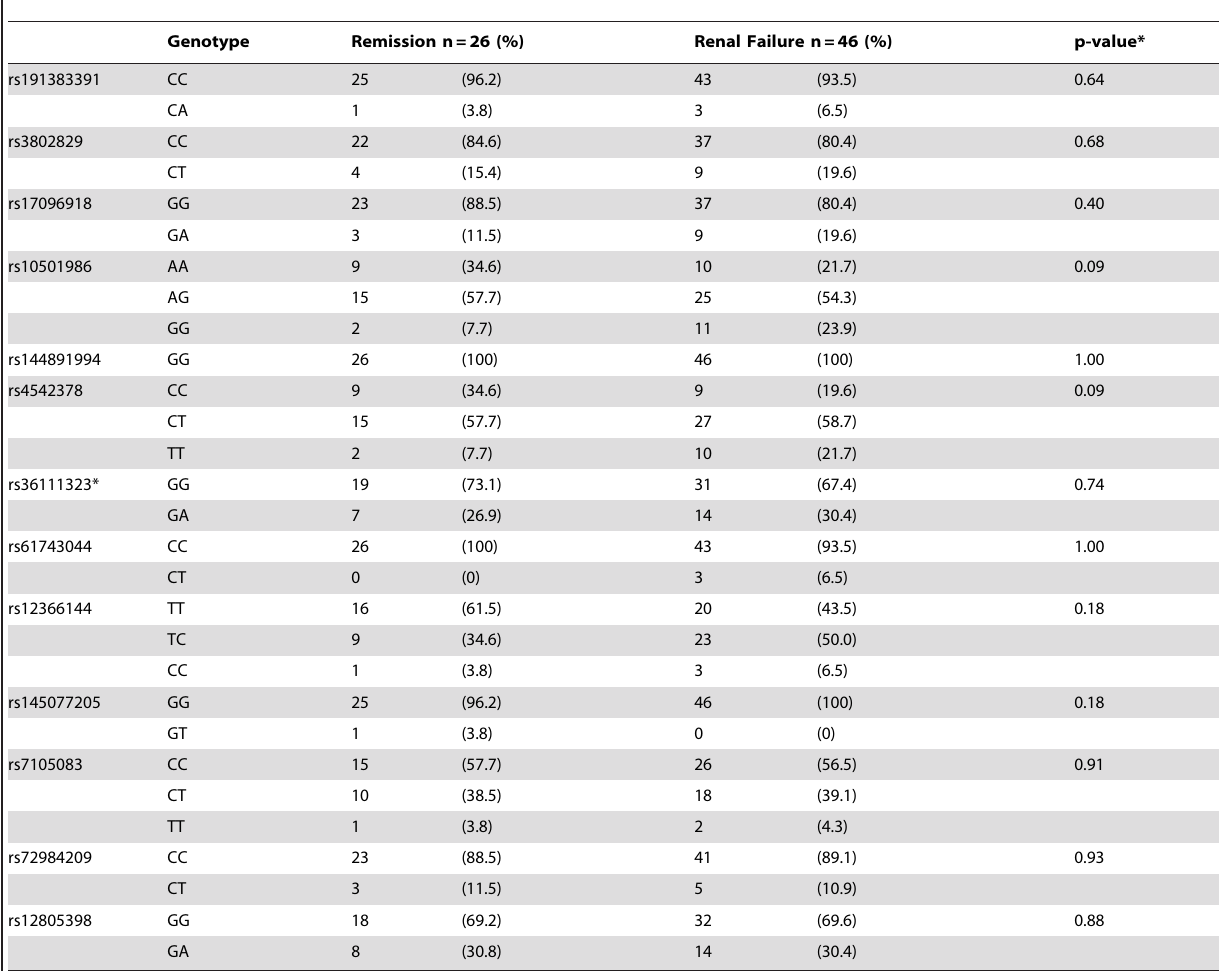
Table 3. Genotypes in iMN patients with clinical remission versus patients with renal failure.